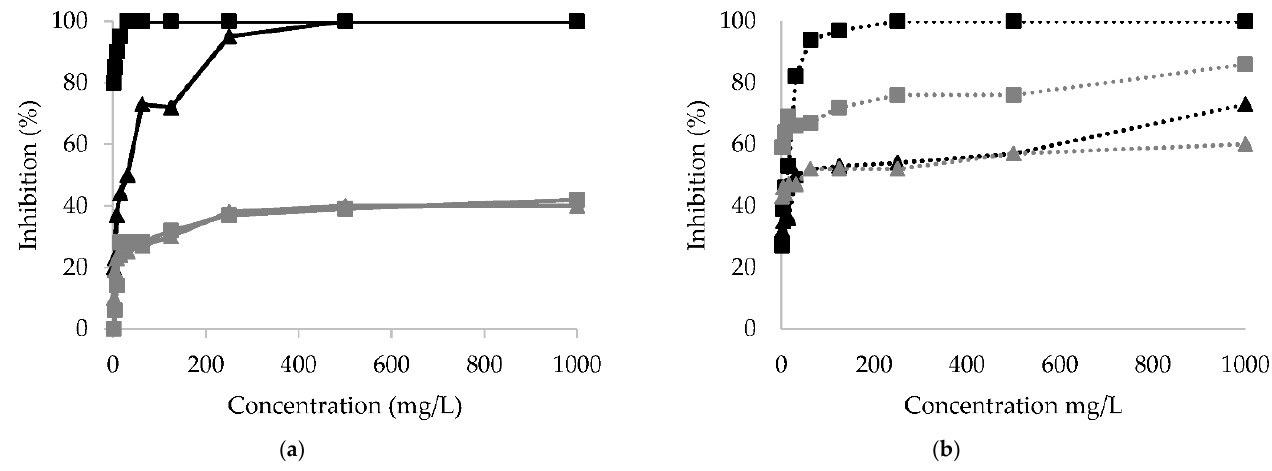
Figure 1. Inhibition percentage for: ( a ) bacteria Clavibacter michiganensis (black line) and Xanthomonas campestris (gray line) and ( b ) fungus Alternaria alternata (black dotted line) and Fusarium oxysporum (gray dotted line) with different concentrations of extracts from P. bollanum ( ■ ) and V. album subsp. austriacum ( ▲ ).